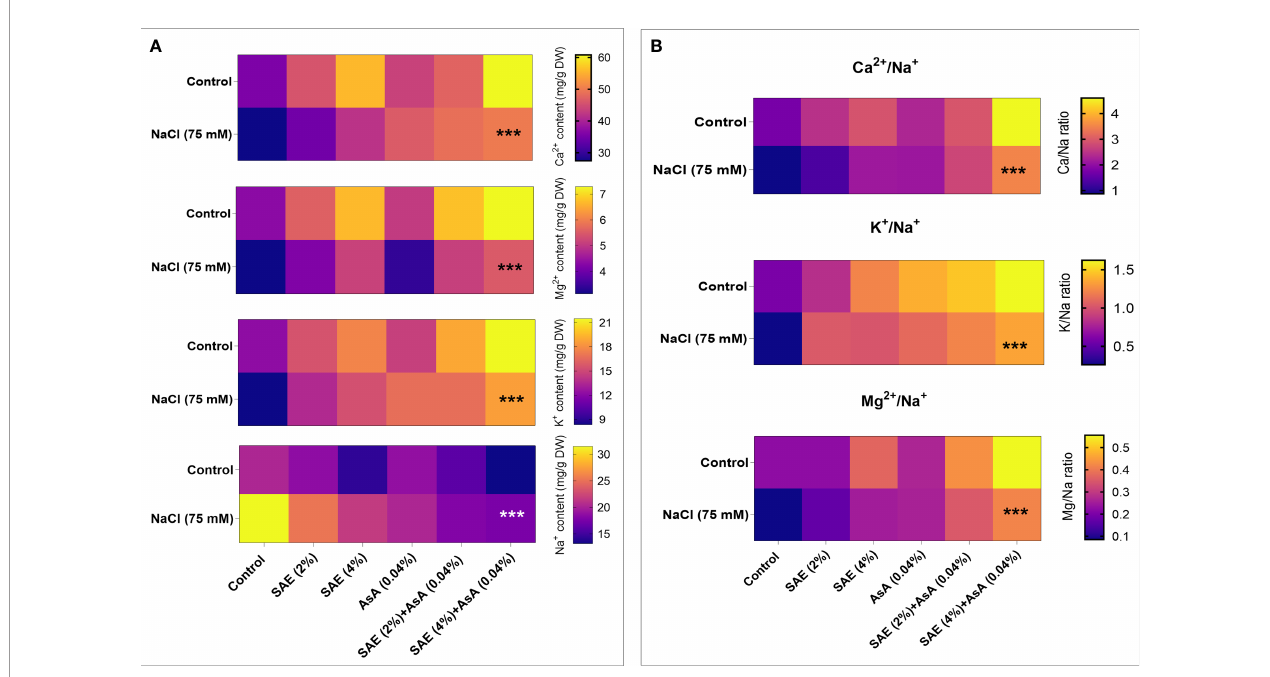
FIGURE 10 | Ionic analysis. (A) sodium, potassium, magnesium; calcium (B) Ca2 + /Na + , K + /Na + , and ratios. Error bars of quantitative data represent ± SEM (*** p < 0.05). DW, dry